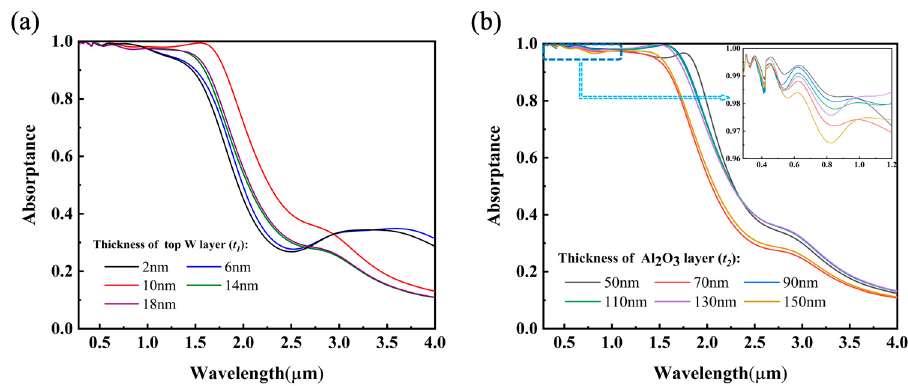
Figure 6. ( a ) Absorptance spectra of absorbers when the thickness ( t 1 ) of the top W layer varies from 2 to 18 nm. ( b ) Absorptance spectra of absorbers when the thickness ( t 2 ) of the intermediate Al 2 O 3 layer varies from 50 to 150 nm.